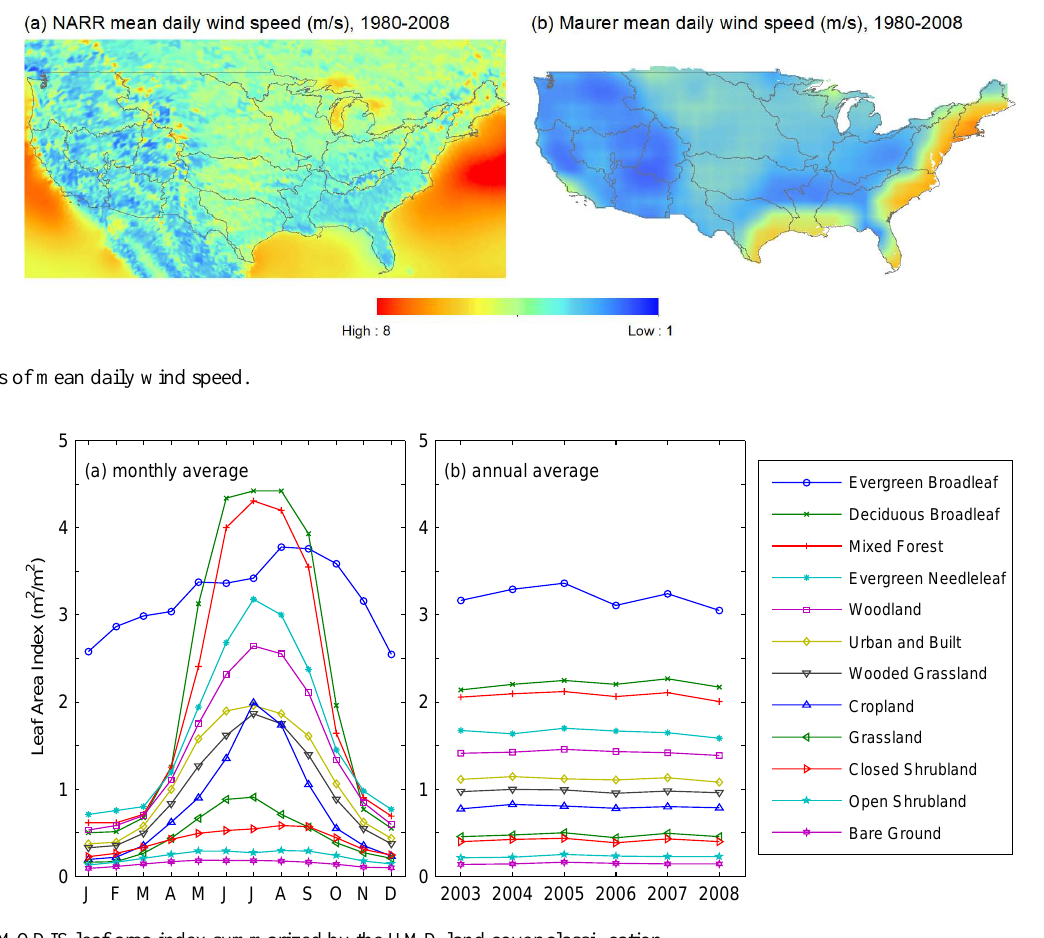
Fig. 6. The MODIS leaf area index summarized by the UMD land cover